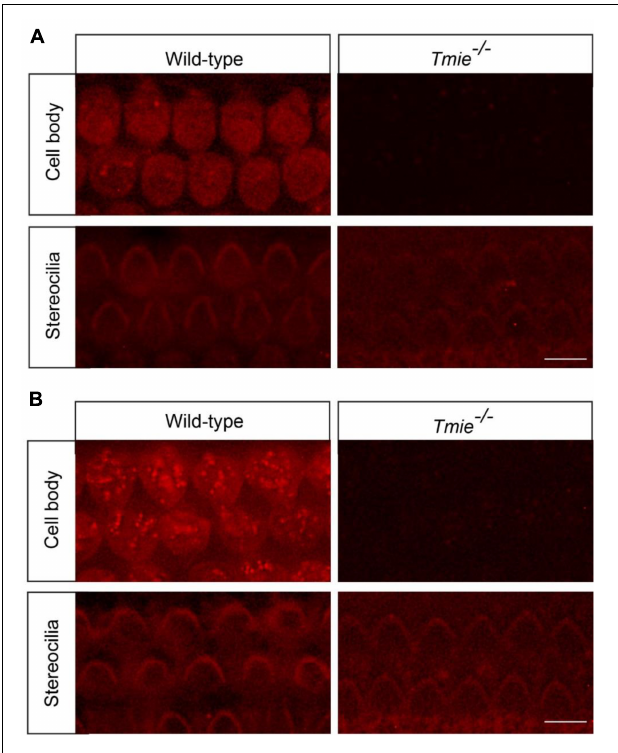
FIGURE 3 | Cisplatin uptake relies on functional mechanotransduction. Cochlear explants dissected from P3 wild-type and Tmie − / − mice were incubated with Texas Red-conjugated cisplatin (TR–cisplatin) for 15 min (A) or 2 h (B) . Note, a robust TR–cisplatin signal was detected in the cell body of the wild-type OHCs. A weak cisplatin signal was detected in the stereocilia in the wild-type and Tmie − / − hair cells. Scale bars: 10 µ